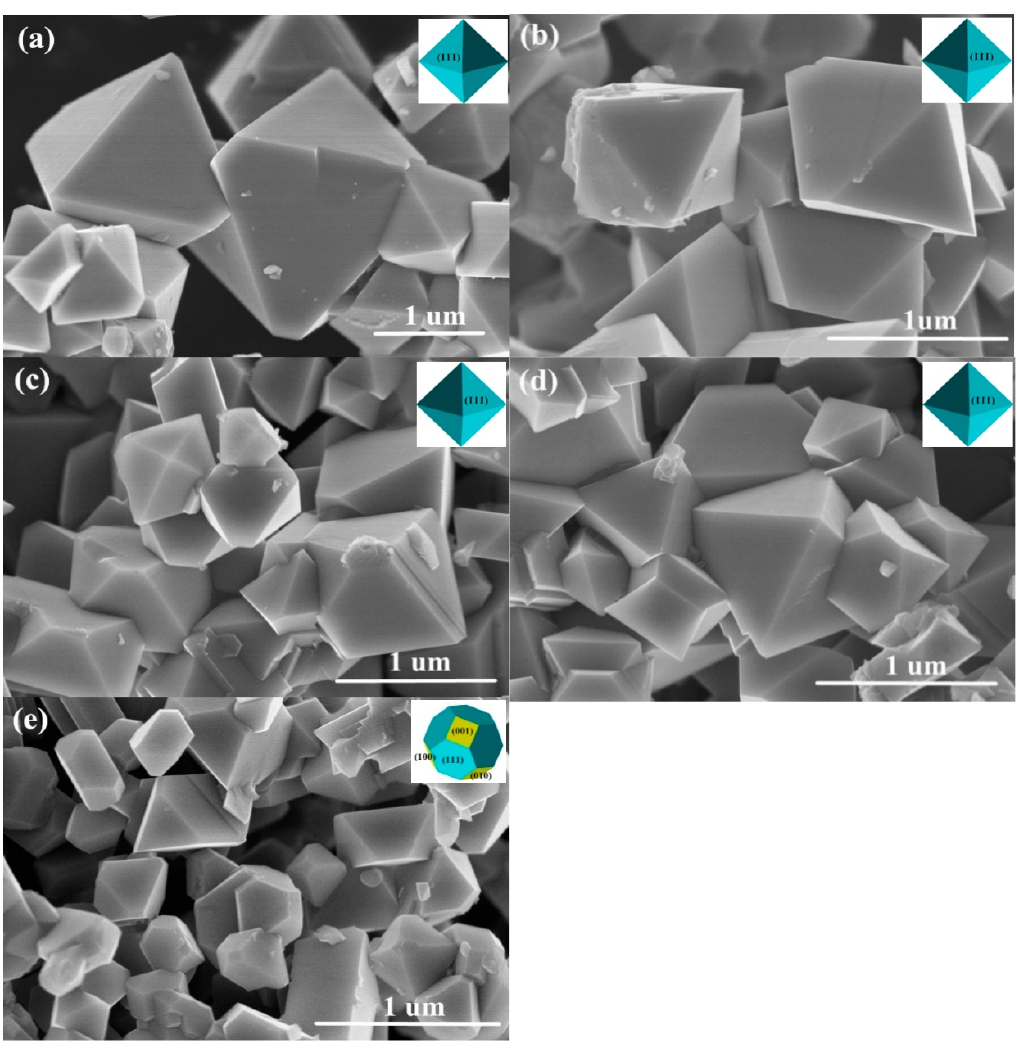
Figure 4. SEM images of pure LNMO ( a ), LNMO-KCl0.02 ( b ), LNMO-KCl0.03 ( c ), LNMO-KF0.01 ( d ), and LNMO-KF0.02 ( e